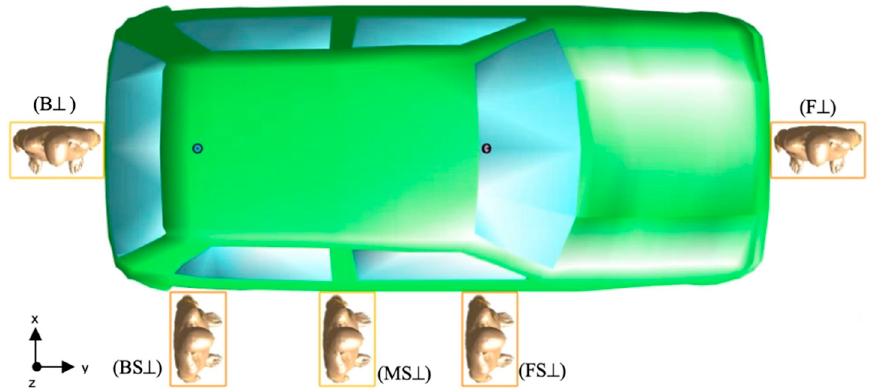
Figure 3. Top view of the human model in the front (F ⊥ ), back (B ⊥ ), front-side (FS ⊥ ), middle-side (MS ⊥ ), and back-side (BS ⊥ ) configurations. The distances between the Huygens’ Box (yellow rectangle) and the antennas are the same as in Figure 2 (top panel).